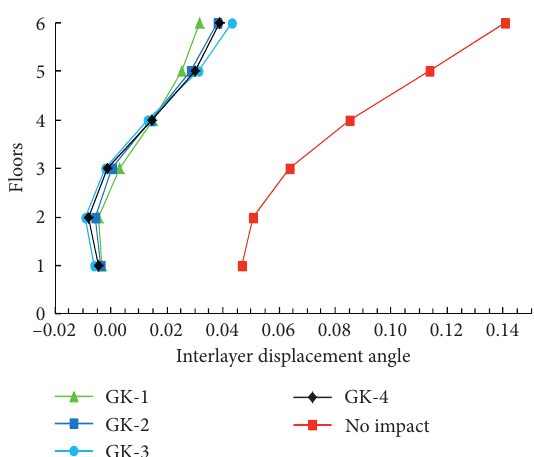
Figure 9: KJ-B interlayer displacement angle (PGA � 0.62g).